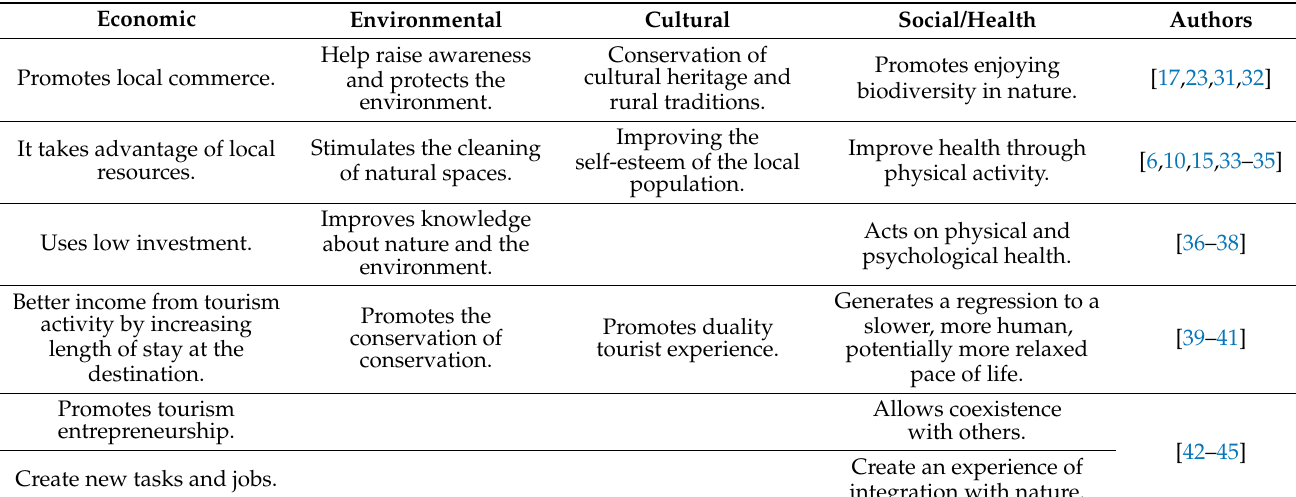
Table 1. Hiking tourism benefits and knowledge